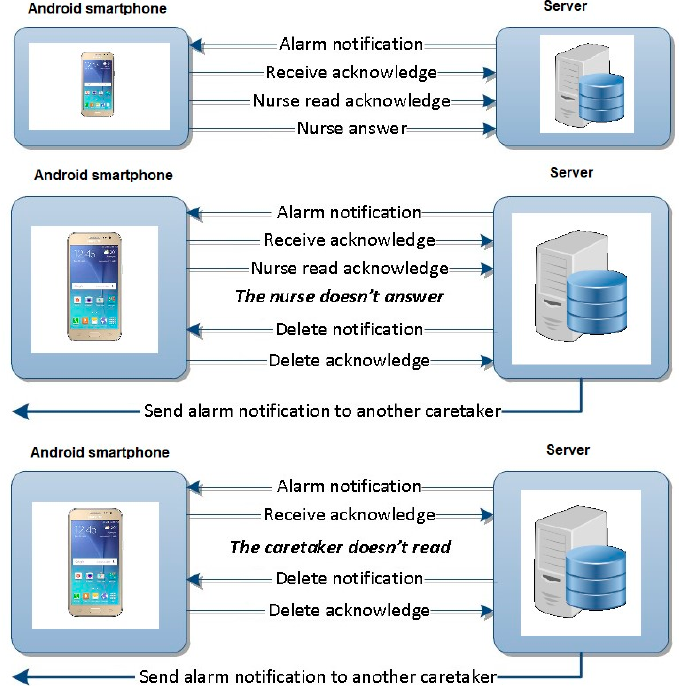
Figure 19. Two-way communication protocols between Caretaker device and Server Subsystem [40].